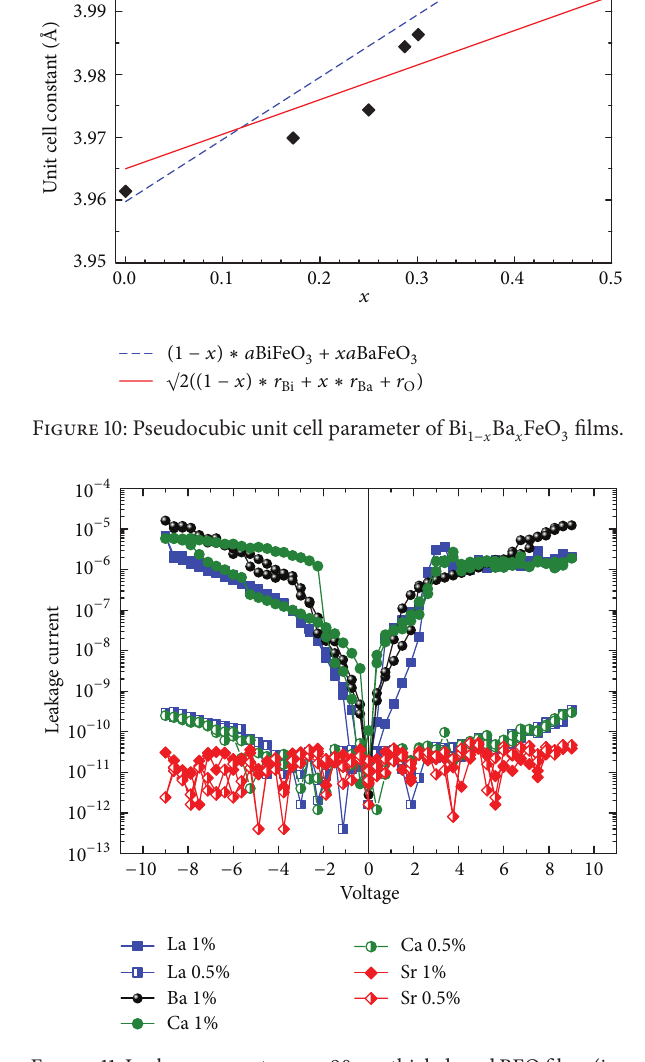
Figure11:Leakagecurrentacross90 nmthickdopedBFOfilms(i.e., the maximum voltage corresponds to